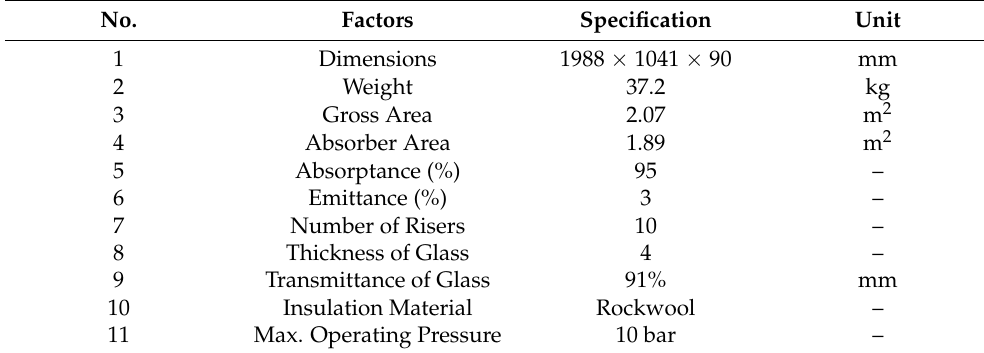
Table 2. Specifications of the flat plate solar collector system. No. Factors